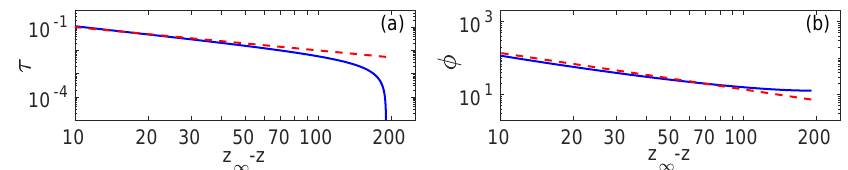
Figure 4. Numerical integration of the coupled system of characteristic ODE (5)–(9): Evolutions during the propagation of the gradient of the momentum τ ( z ) ( a ) and intensity envelope of the incoherent pulse φ ( z ) ( b ) along a characteristic nearby the singularity. Their evolutions exhibit the power-law divergence ∼ ( z ∞ − z ) − 1 predicted by the theory in Equation (11) (dashed red lines) ( σ = − 1, τ